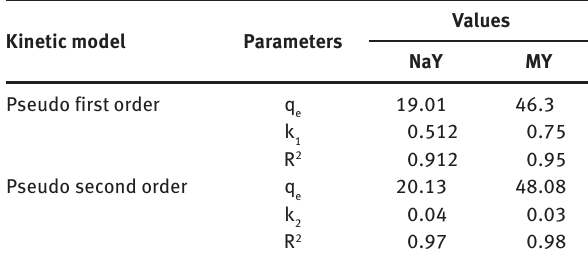
Figure 10: The Langmuir separation factor (R and hierarchical MY.